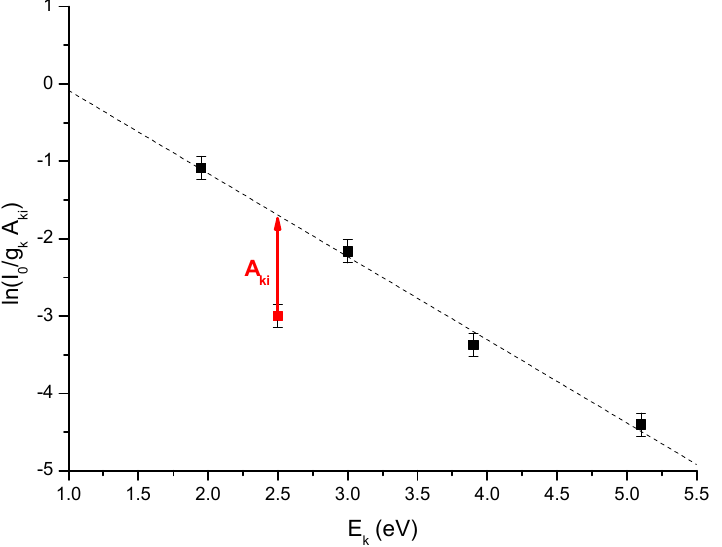
Figure 4. Determination of the unknown A ki of a spectral line from the Boltzmann plot of the same species.